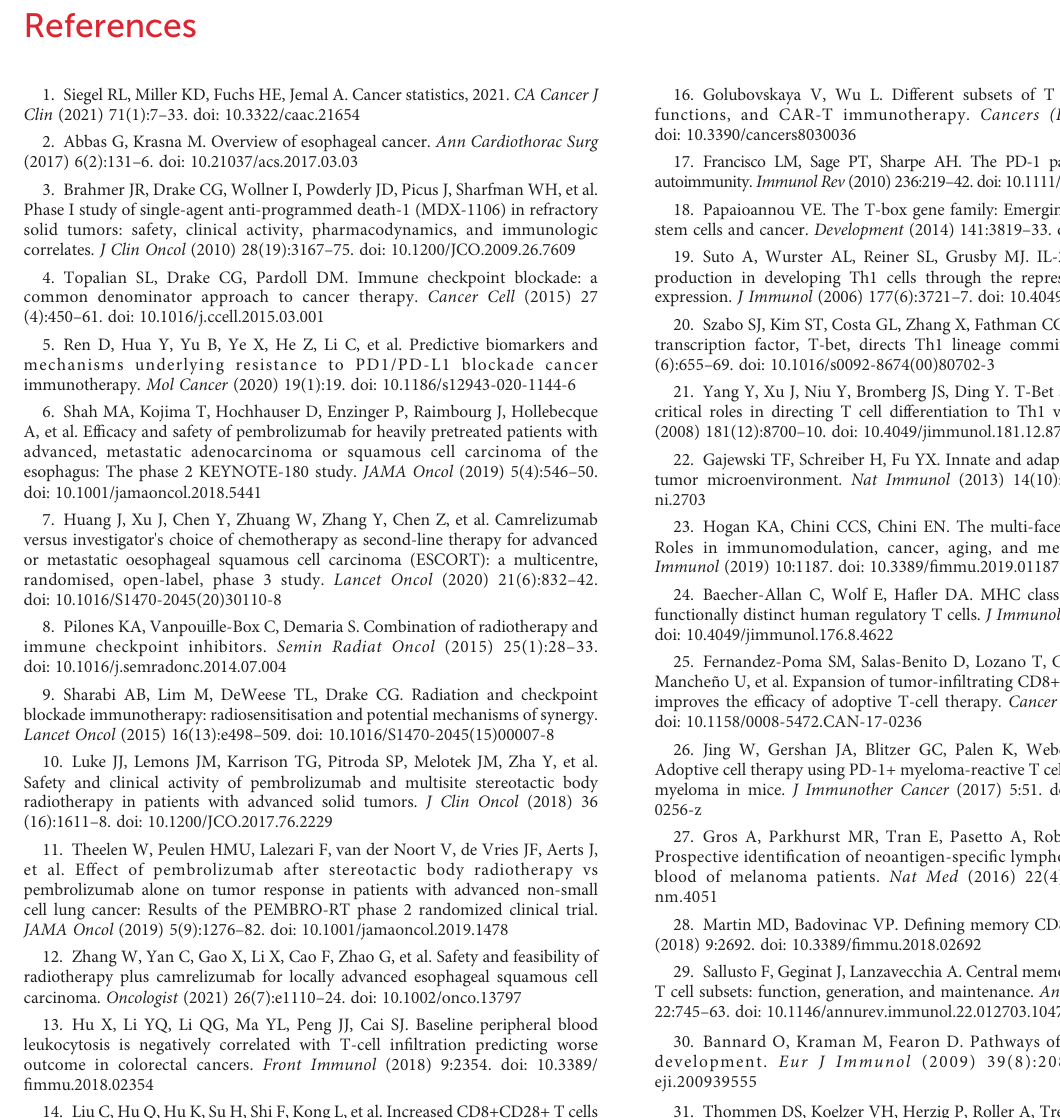
FIGURE S4 Differentiation subsets of memory T cells in PD-1+ and PD-1- CD8+ T cells. (A) Tem percentage during RT plus immunotherapy treatment. (B) Tcm percentage during CCRT treatment.